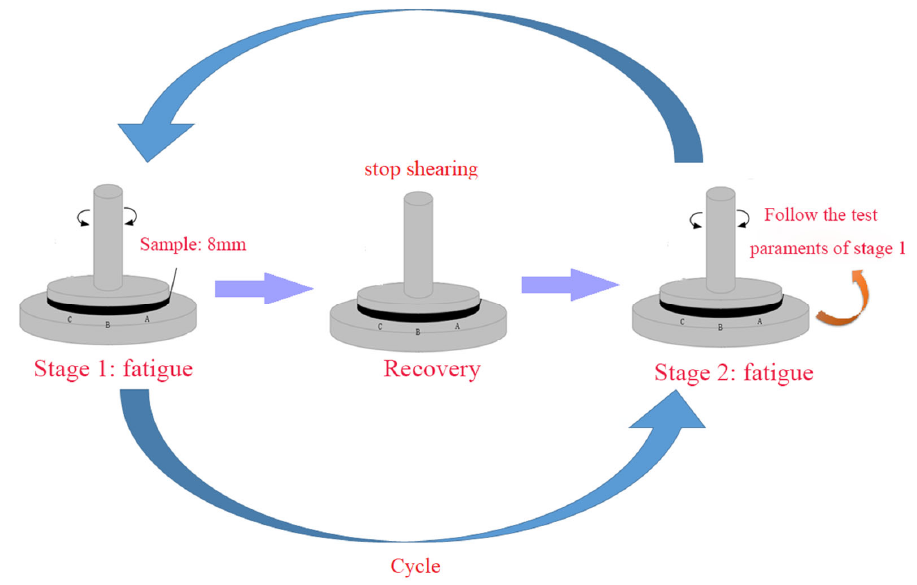
Figure 2. Rheological recovery test method.